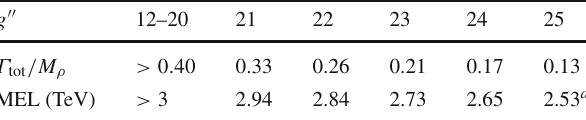
Table6 Theupdatedmassexclusionlimits(MEL)forthetBESSvector resonance triplet without the direct interactions for various values of g (cid:2)(cid:2) g (cid:2)(cid:2)